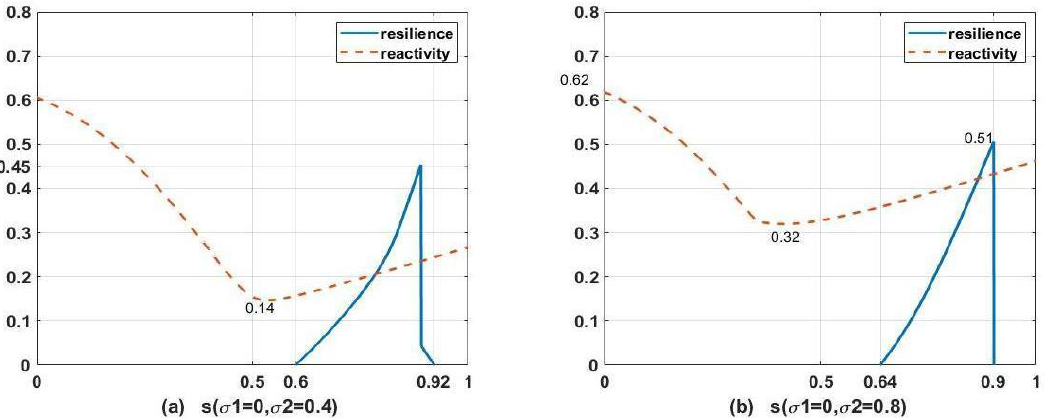
Figure 6. Resilience and reactivity of the system (7) when the predator is disturbed (mean square